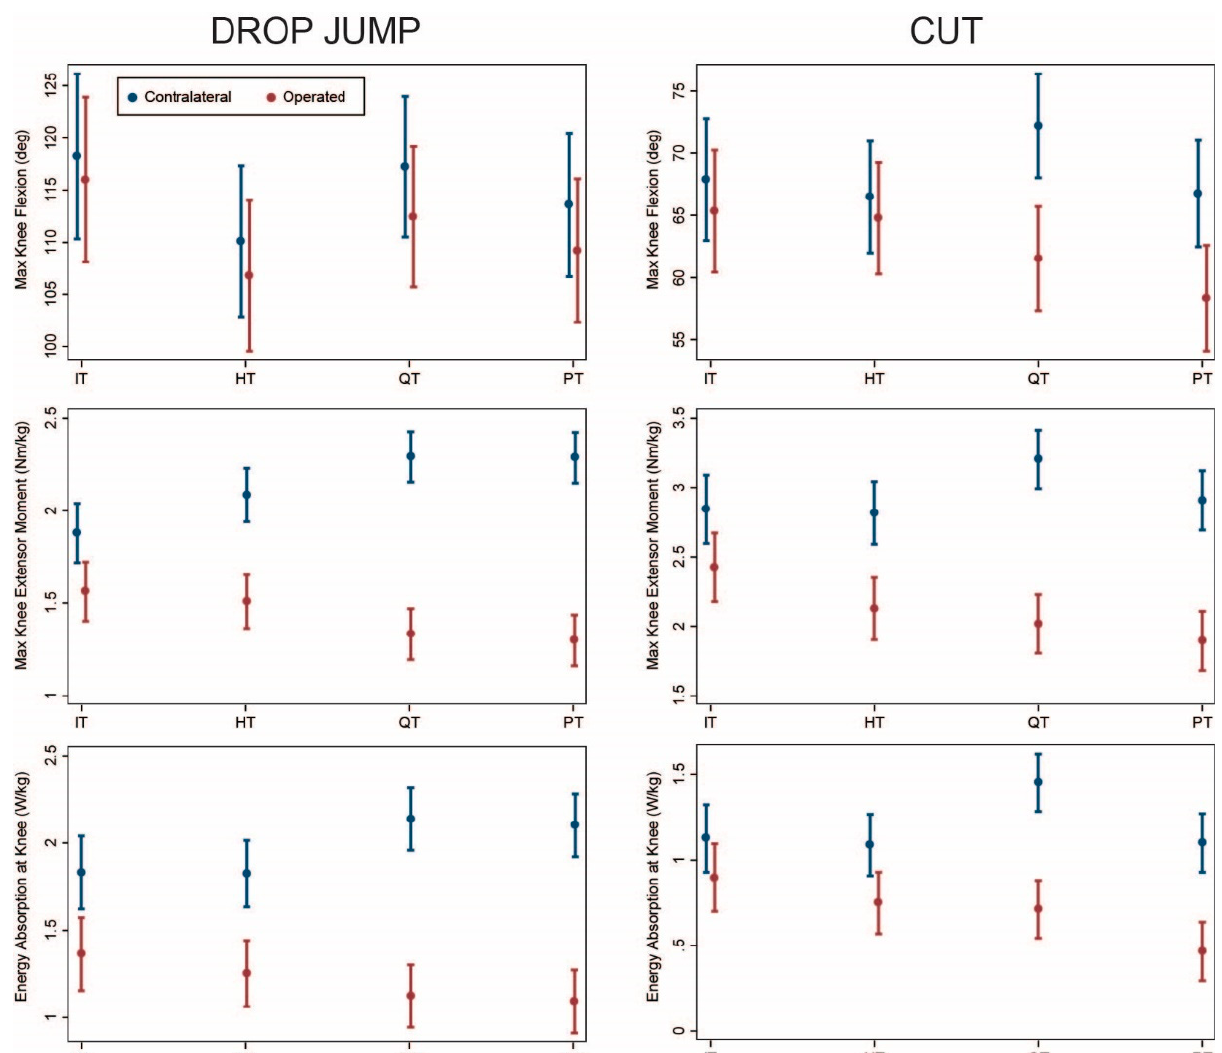
Figure 4. Comparison of operated (red) and contralateral (blue) limbs by graft type (model predicted mean and 95% confidence interval) for patients under 16 years of age and visits at least 6 months post-surgery. IT: iliotibial band; HT: hamstring tendon; QT: quadriceps tendon; PT: patellar tendon.